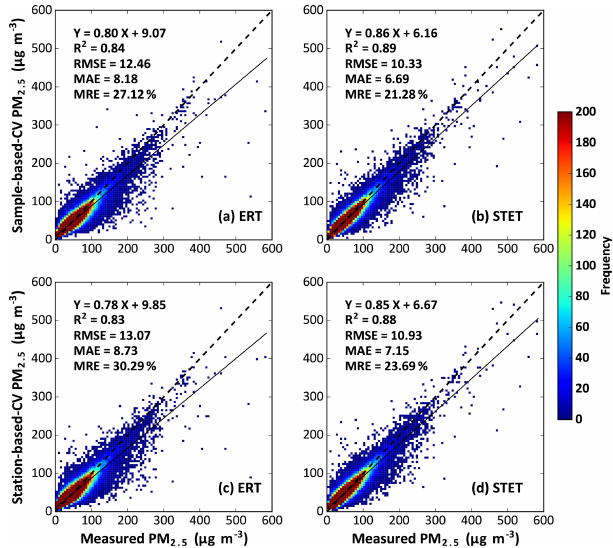
Figure 5. Density scatter plots of (a, b) out-of-sample and (c, d) out-of-station 10-CV results for the (a, c) ERT and (b, d) STET models at the daily level in 2018 for mainland China. Statistical metrics are given in each panel, along with the lin- ear regression relation, including the correlation of determination ( R 2 ), the root-mean-square error (RMSE), the mean absolute error (MAE) and the mean relative error